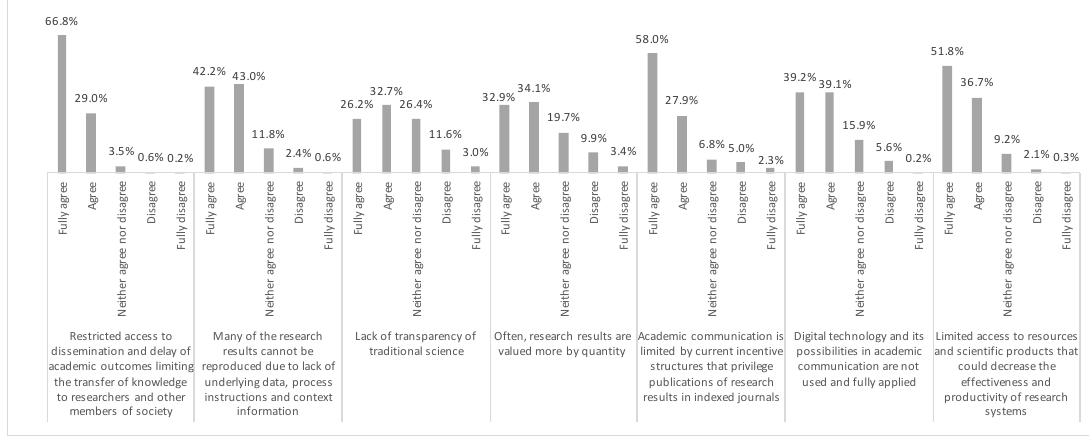
Figure 5. The deficiencies of the current system that open science could overcome, according to Colombian researchers.